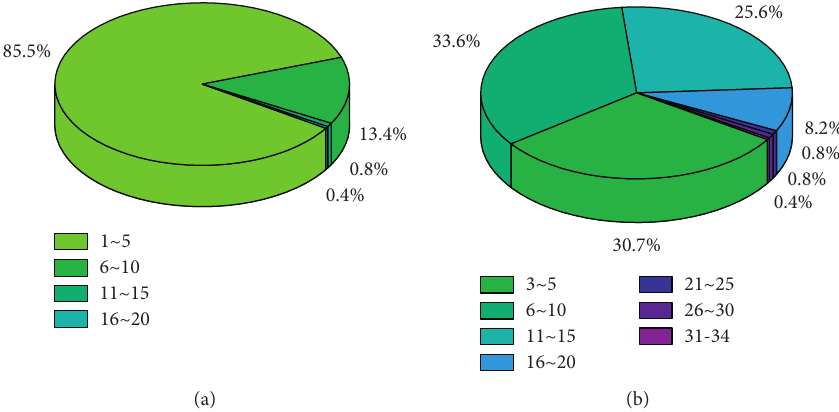
Figure 6: Distribution characteristics of the revealed karst geology in this area. (a) Distribution statistical diagram of the karst cave height. (b) Distribution statistical diagram of the distance between the karst cave and tunnel.